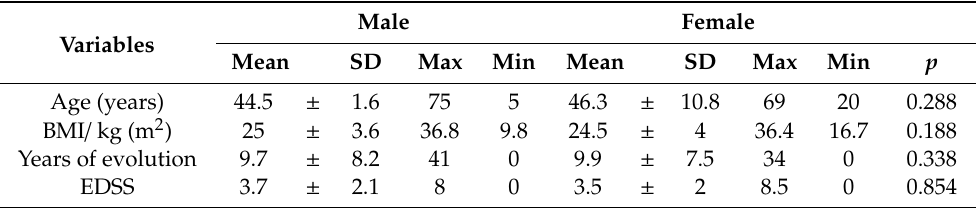
Table 1. Characteristics of the sample according to gender.